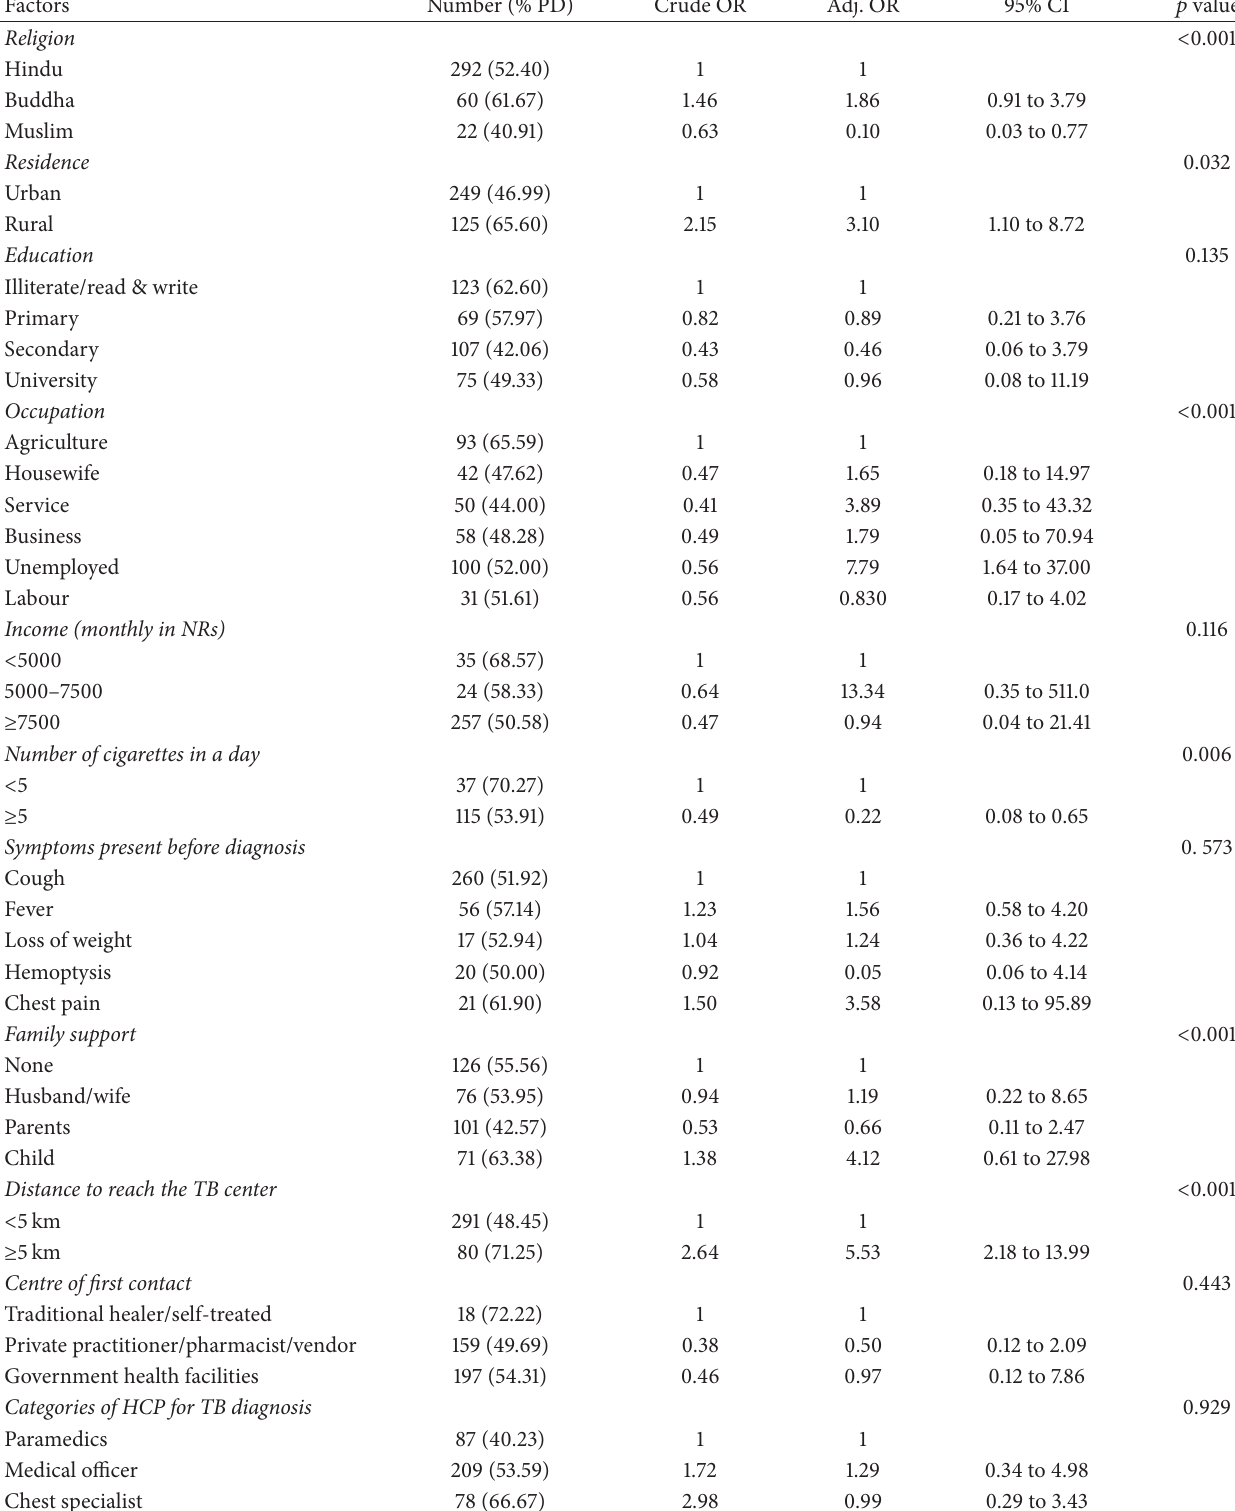
Table 3: Factors associated with patient delay: multivariate